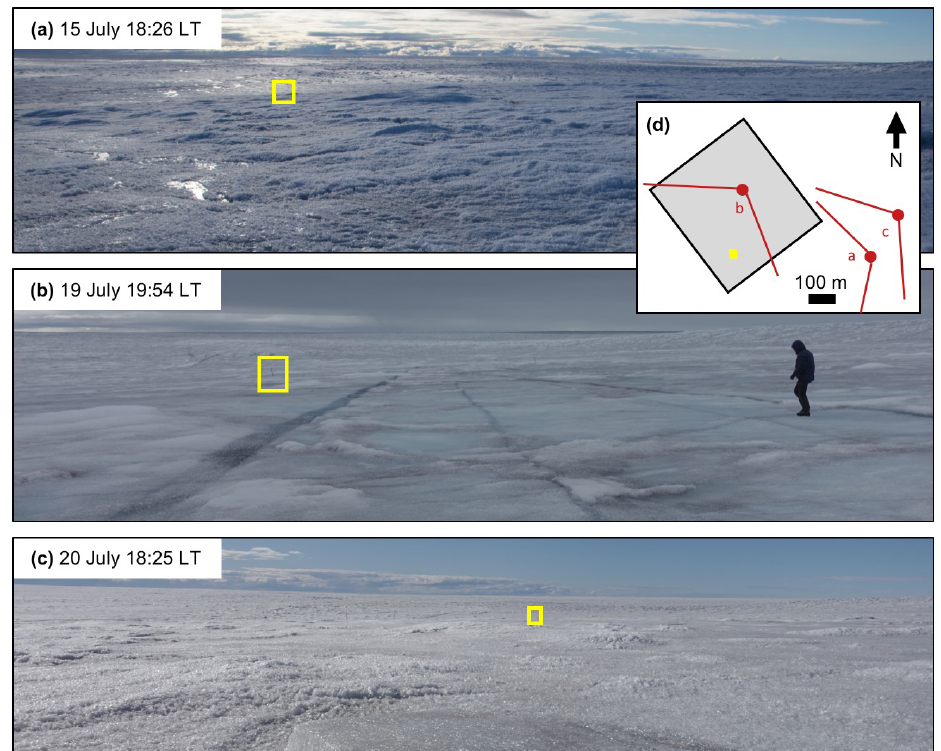
Figure D1. Oblique surface photos of the UAS survey area at S6, all angled approximately west–south-west. Yellow rectangle in each photo shows location of the same ∼ 1 . 5m tall pole used to co-register the photos. All capture times are in local time (LT). (a) 15 July, before snowfall. (b) 19 July, towards the end of stormy conditions that dominated 18–19 July. (c) 20 July, following a return to shortwave-dominant energy balance conditions. (d) Sketch map showing approximate positions from which each photo was taken. UAS survey area indicated by gray box. Location of pole used to co-register images indicated by yellow square.